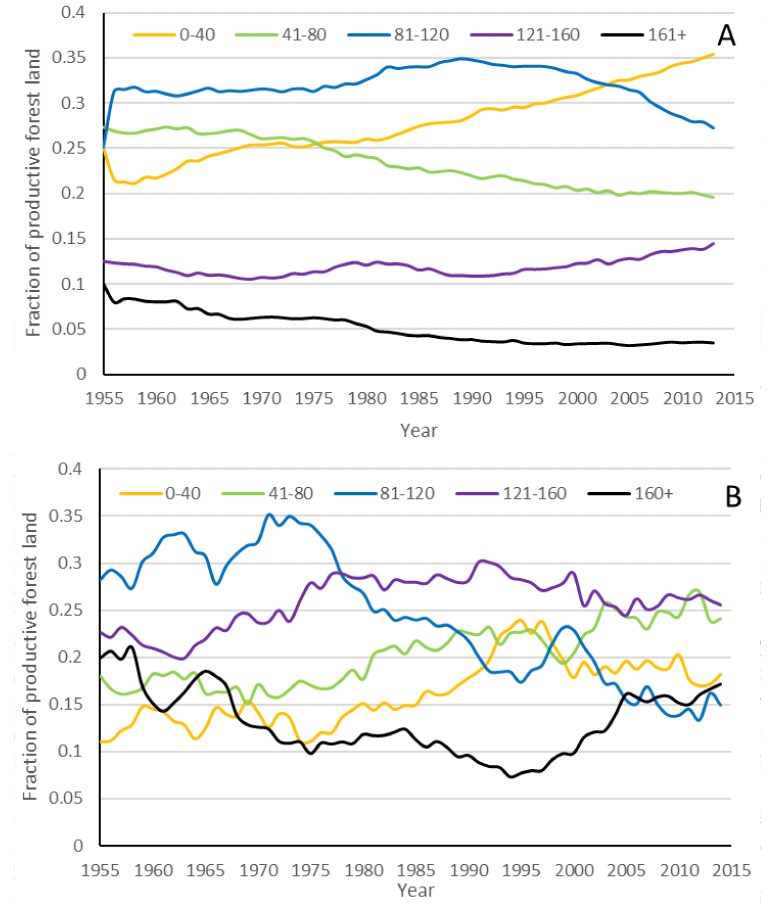
Figure 3. Change in forest age distribution (running 5-year average) based on data from 1955 to 2015 outside protected areas for ( A ) north Sweden and ( B ) the area above the mountain forest border (MFB); data from the Swedish National Forest Inventory (NFI). Data from the area above the MFB are based on fewer field sample points in the NFI and hence show larger statistical